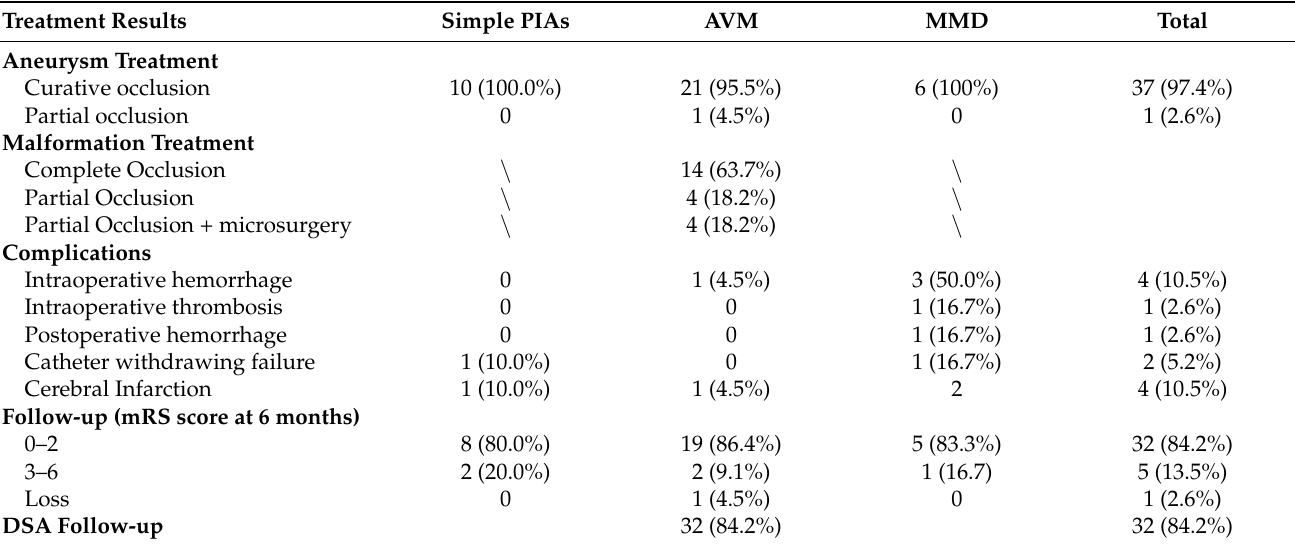
Table 2. Treatment outcome and